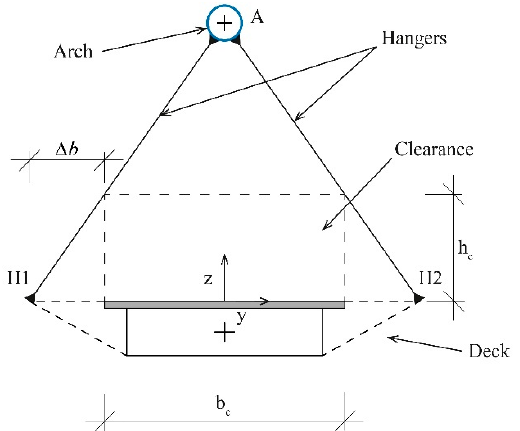
Figure 24. Clearance requirements over a generic symmetrical cross-section of a DAB.